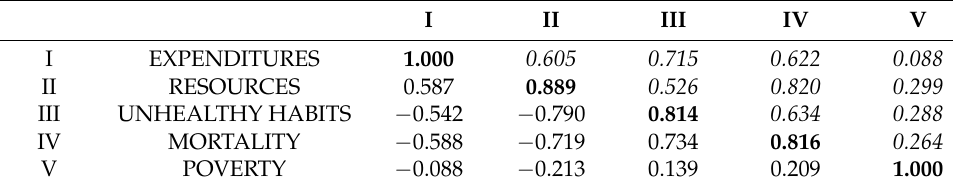
Table 3. Discriminant validity.